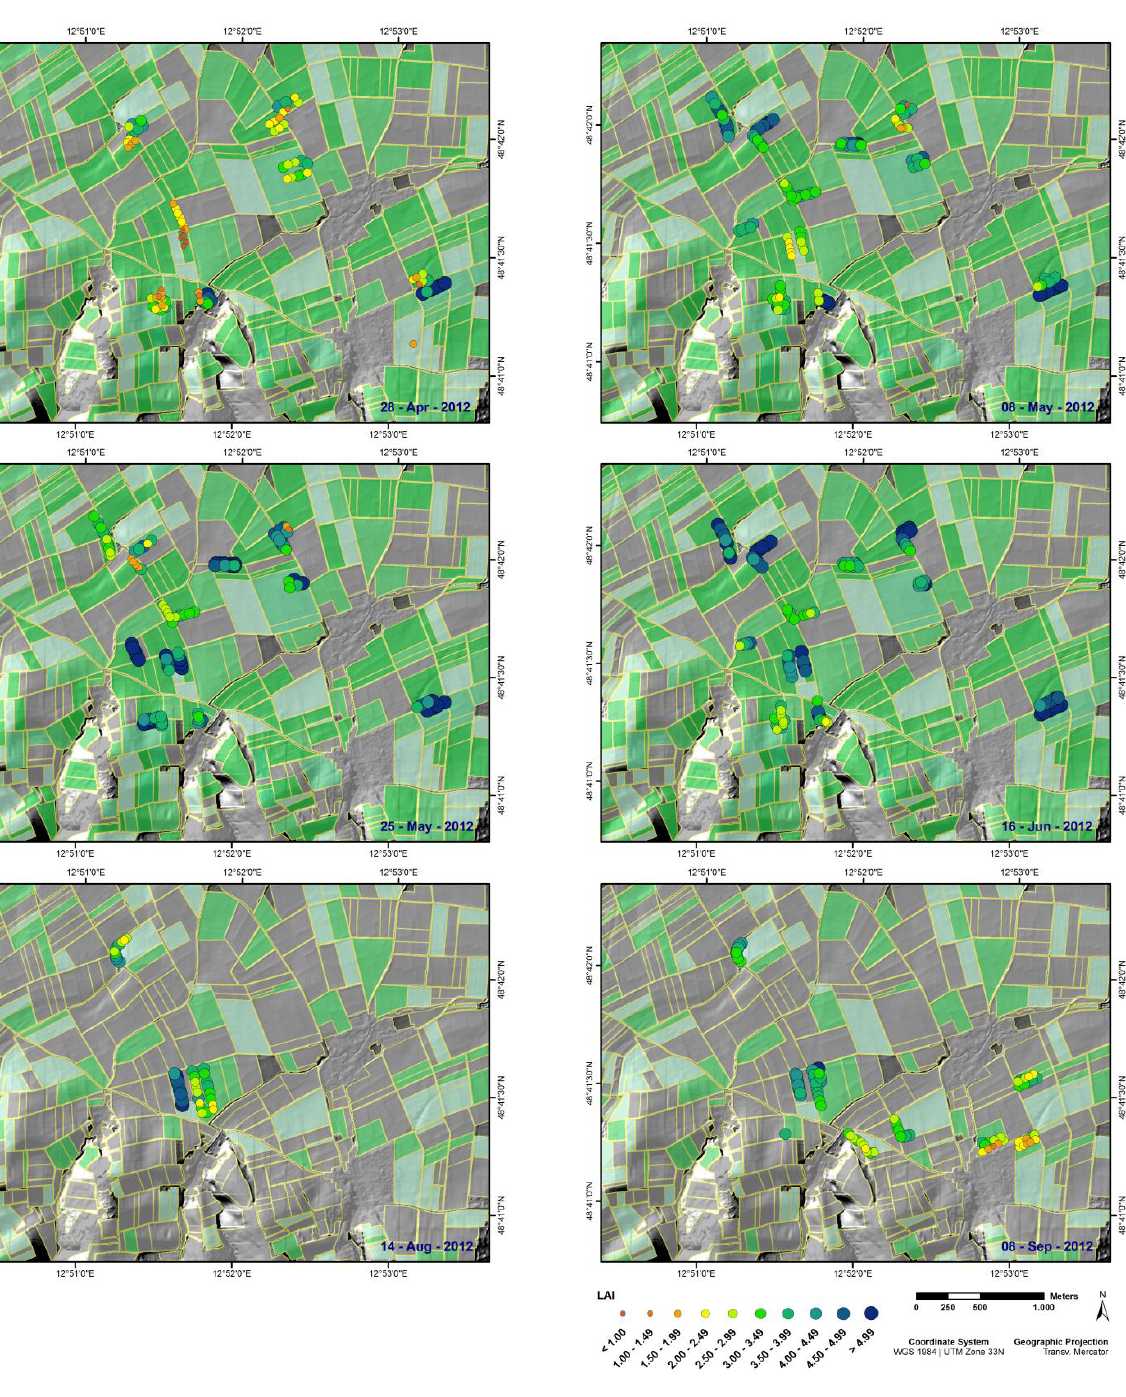
Figure 1. Locations of the elementary sampling units, presented as collected LAI values, for the six airborne acquisition dates (UL: 28 April 2012, UR: 8 May 2012, ML: 25 May 2012, MR: 16 June 2012, LL: 12 August 2012, LR: 8 September 2012). Fields that are